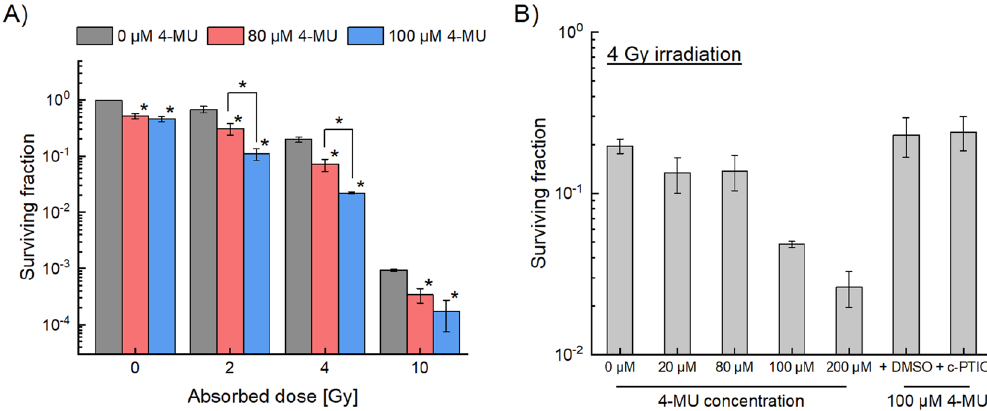
Figure 1. Measured cell survival fraction of HT1080 treated with 4-MU and X-ray irradiation. ( A ) The logarithmic surviving fraction of HT1080 cells irradiated with 0, 2, 4 and 10 Gy under the 4-MU concentrations of 0, 80 and 100 μM, and ( B ) the survival of 4 Gy irradiation with additional 4-MU concentrations of 20 and 200 μM, and 100 μM 4-MU with the ROS inhibitor (1% DMSO) or the NO inhibitor (40 μM c-PTIO). Note that (*) on the bar graph represents p < 0.05 compared to the data under the 0 μM 4-MU, and bracketed asterisks represent significant differences of p < 0.05 between the two